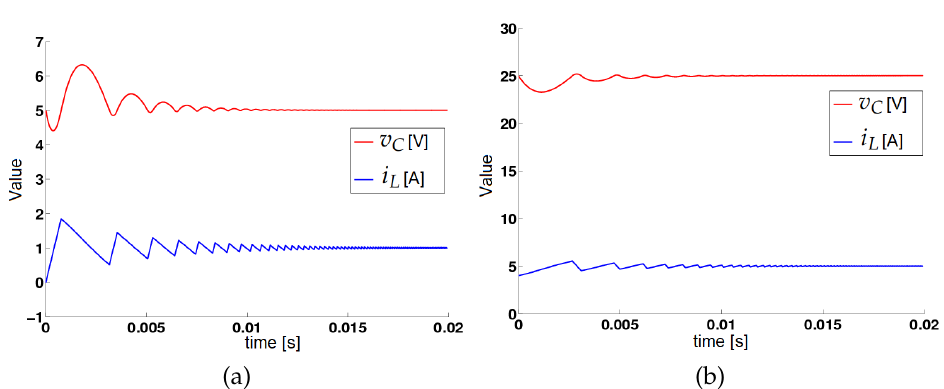
Figure 10. Temporal dynamics of ( a ) low reference voltage V ref = 5 V and ( b ) high reference voltage V ref = 25 V.